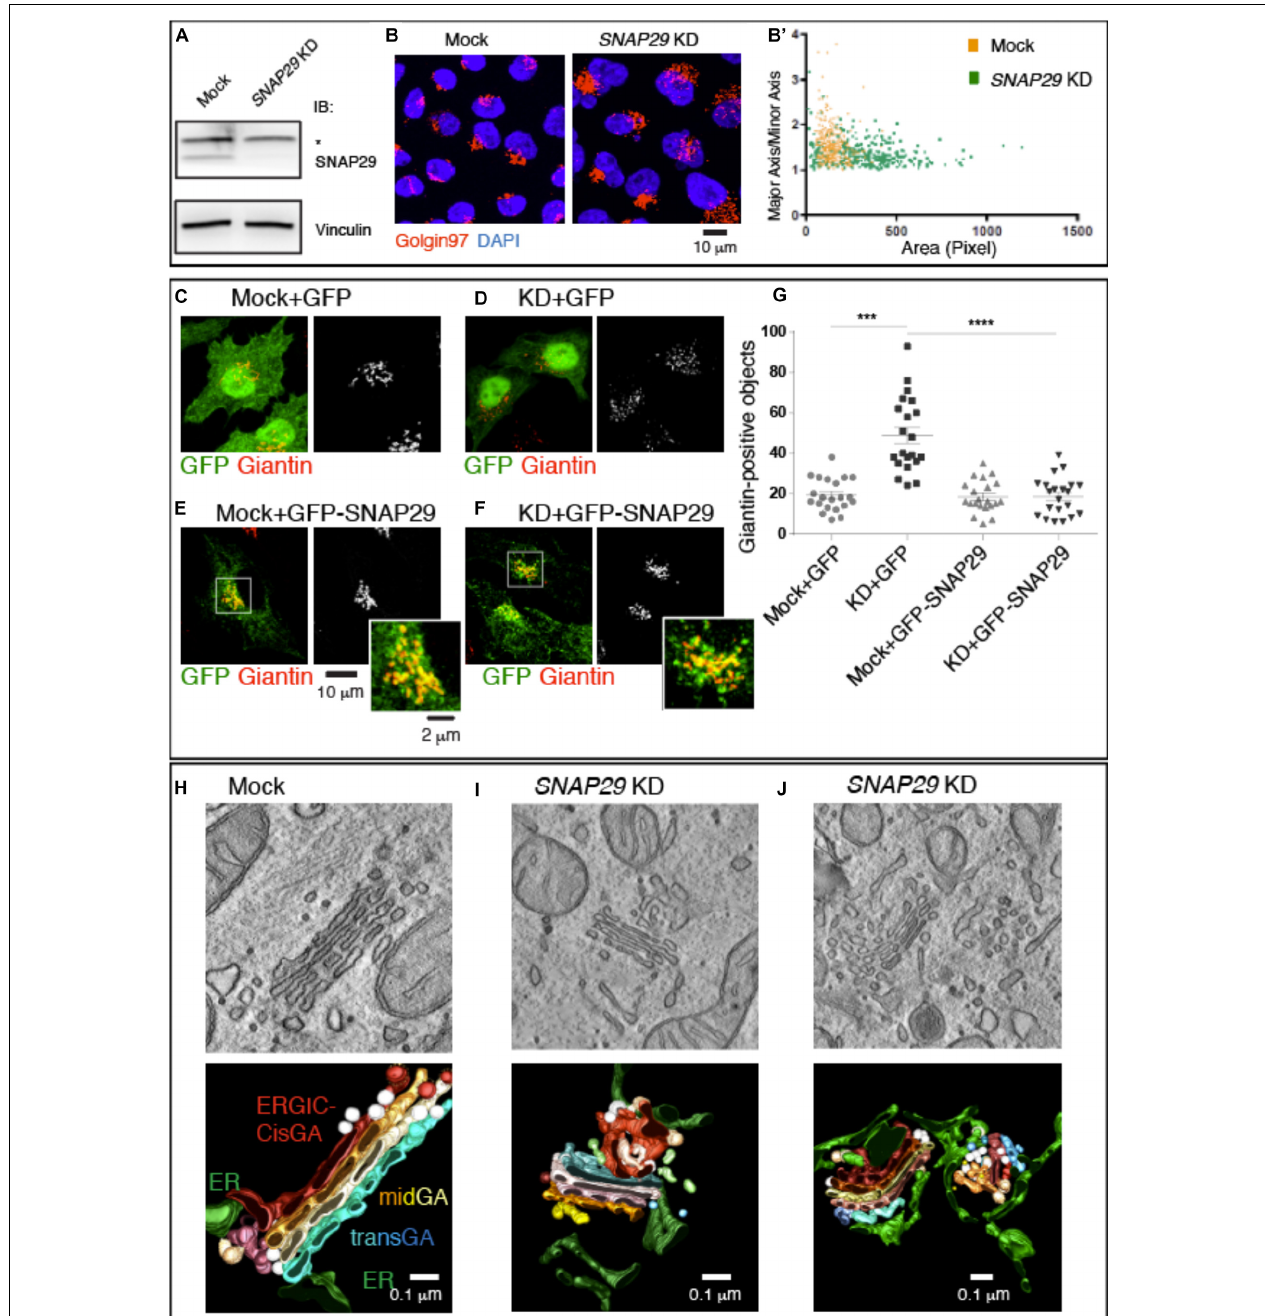
FIGURE 1 | SNAP29 is required to support correct Golgi apparatus (GA) architecture. (A) Immunoblotting of total proteins from mock and SNAP29-depleted (KD) HeLa cell protein with the indicated antibodies. The asterisk indicates the presence of a non-specific band recognized by anti-SNAP29. Snap29 is efficiently depleted upon KD. (B) Max Projections of mock and SNAP29 KD HeLa cells, stained as indicated. (B’) Measurement of the Golgin97-positive area of cells as in panel (B) . The area of each measured GA is shown on the x -axis, while the ratio of the length of the major axis over the minor axis of the GA is shown on the y -axis. Depleted cells display a larger and rounder GA. (C–F) Max Projections of mock (C,E) and SNAP29 KD HeLa cells (D,F) or, in addition, over-expressing the indicated transgene (E,F) , stained as indicated. (G) Quantification of the number of Giantin-positive objects. The mean with standard error of the mean is shown, and the p -value is obtained by one-way ANOVA with Tukey’s multiple-comparisons analysis. GA alterations upon SNAP29 depletion are rescued expression of GFP–SNAP29, which per se does not alter GA architecture. (H–J) Electron microscopy sections of mock (H) and SNAP29-depleted HeLa cells (I,J) . 3D tomographic reconstruction of encompassing sections is shown below. In addition to the indicated pseudo-coloring, COPI-coated vesicles are in white, and COPII-coated buds and tubules are in light brown. Clathrin-dependent vesicles are in light blue. SNAP29 depletion leads to GA vesiculation, endoplasmic reticulum (ER)–Golgi intermediate compartment tabulation, and ER